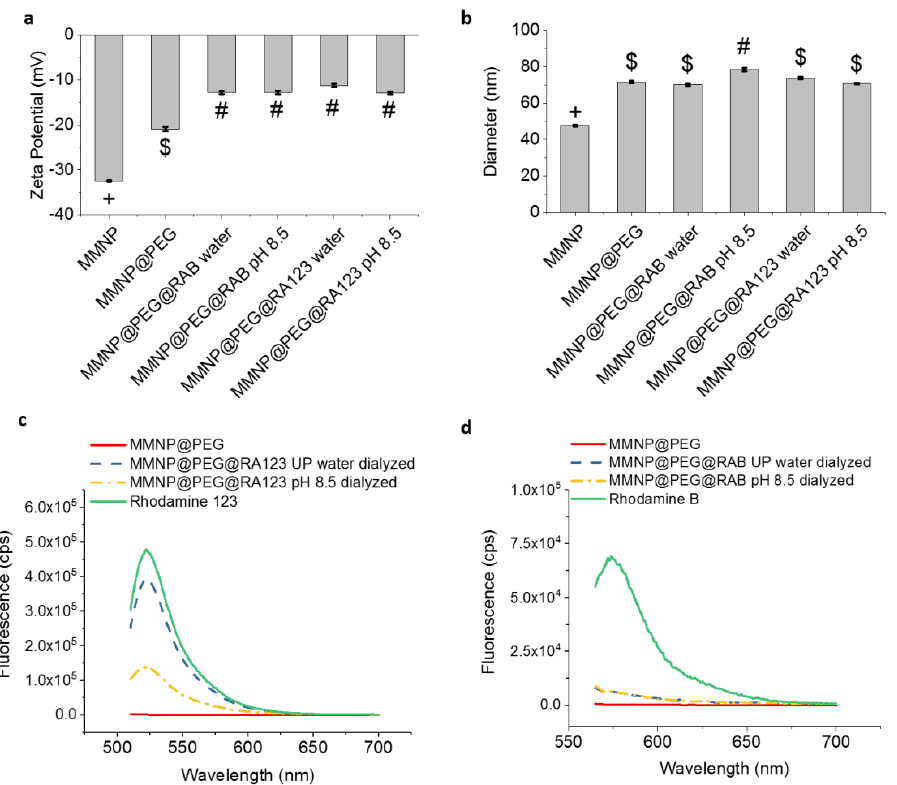
Figure 7. Fluorescence, hydrodynamic diameter, and zeta potential of rhodamine